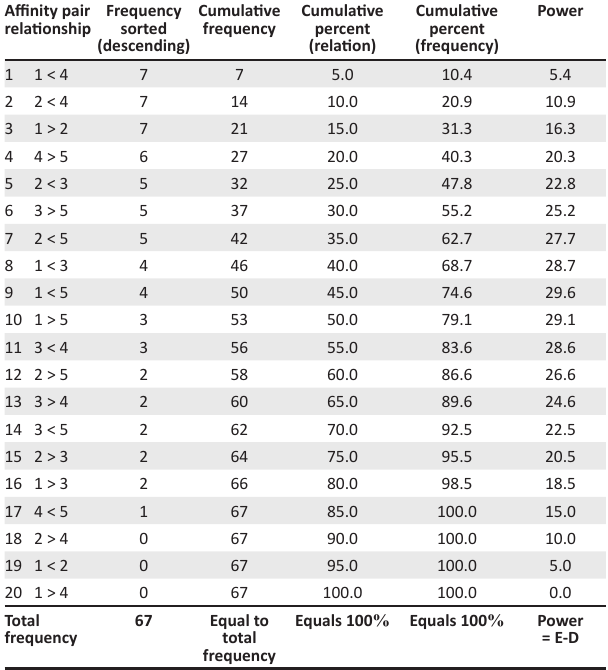
TABLE 3: Pareto and power analysis.